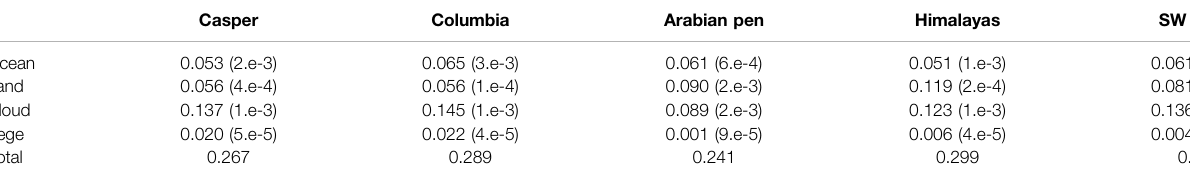
TABLE 2 | The average fraction of area covered by different re fl ectors in the whole EPIC image ( n j /N ) and associated standard deviation for selected fi ve wavelengths. Casper